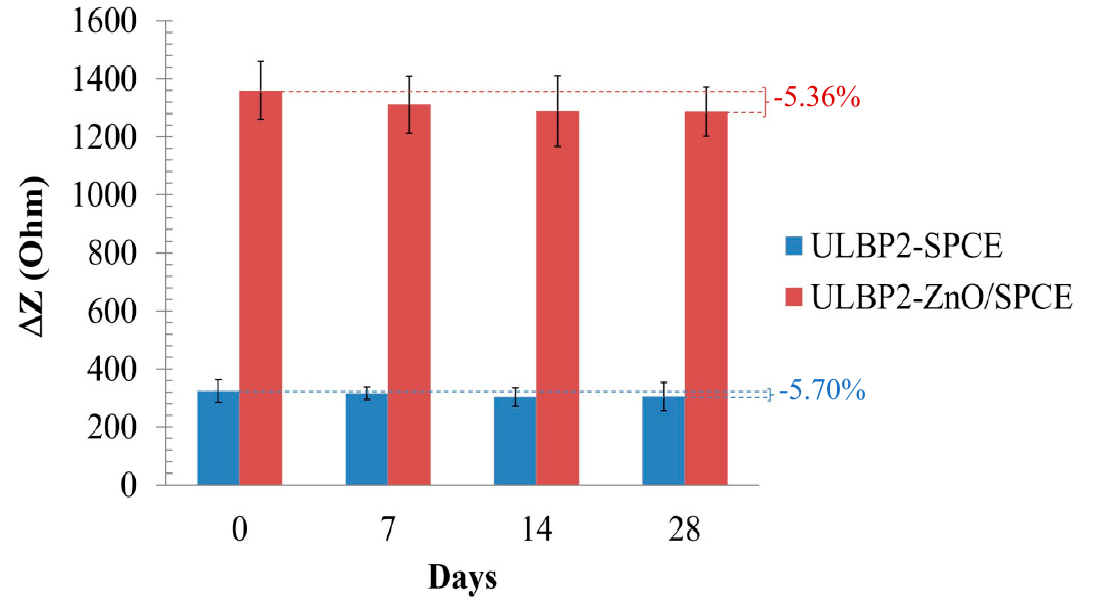
Figure 10. The life-span test for the ULBP2-SPCE and ULBP2-ZnO / SPCE immunosensors. Table 3. Repeatability tests for the ULBP2-SPCE and ULBP2-ZnO / SPCE immunosensors.